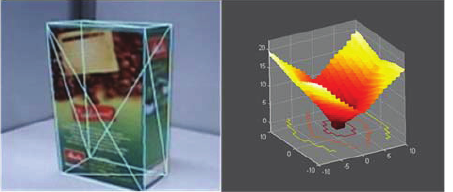
Figure 2. Interest Point Based 3D tracking technique integrated with a Particle Filter.